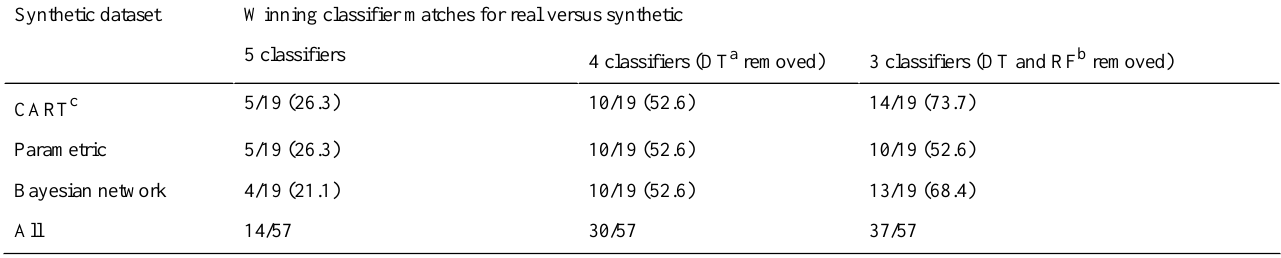
Table 5. Number of instances where the winning classifier trained on synthetic data matches the winning classifier trained on real data across 19 datasets.